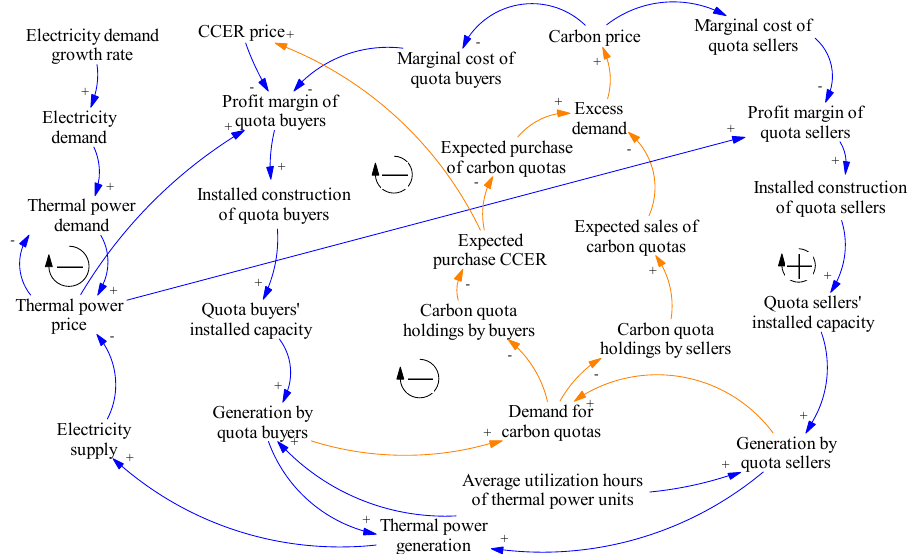
Figure 6. Interaction causal cycle diagram of carbon trading market and power market.